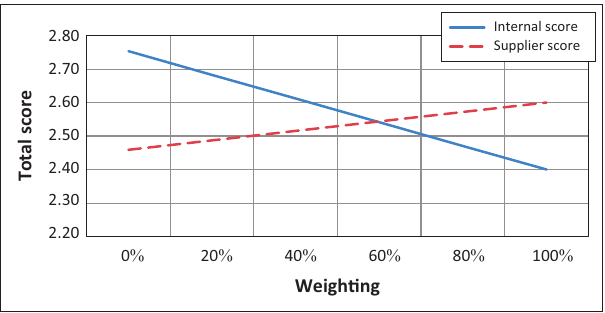
FIGURE 2: Service area